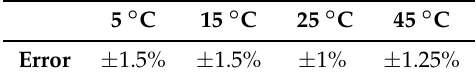
Table 3. Model error at different T ◦ in the SOC window